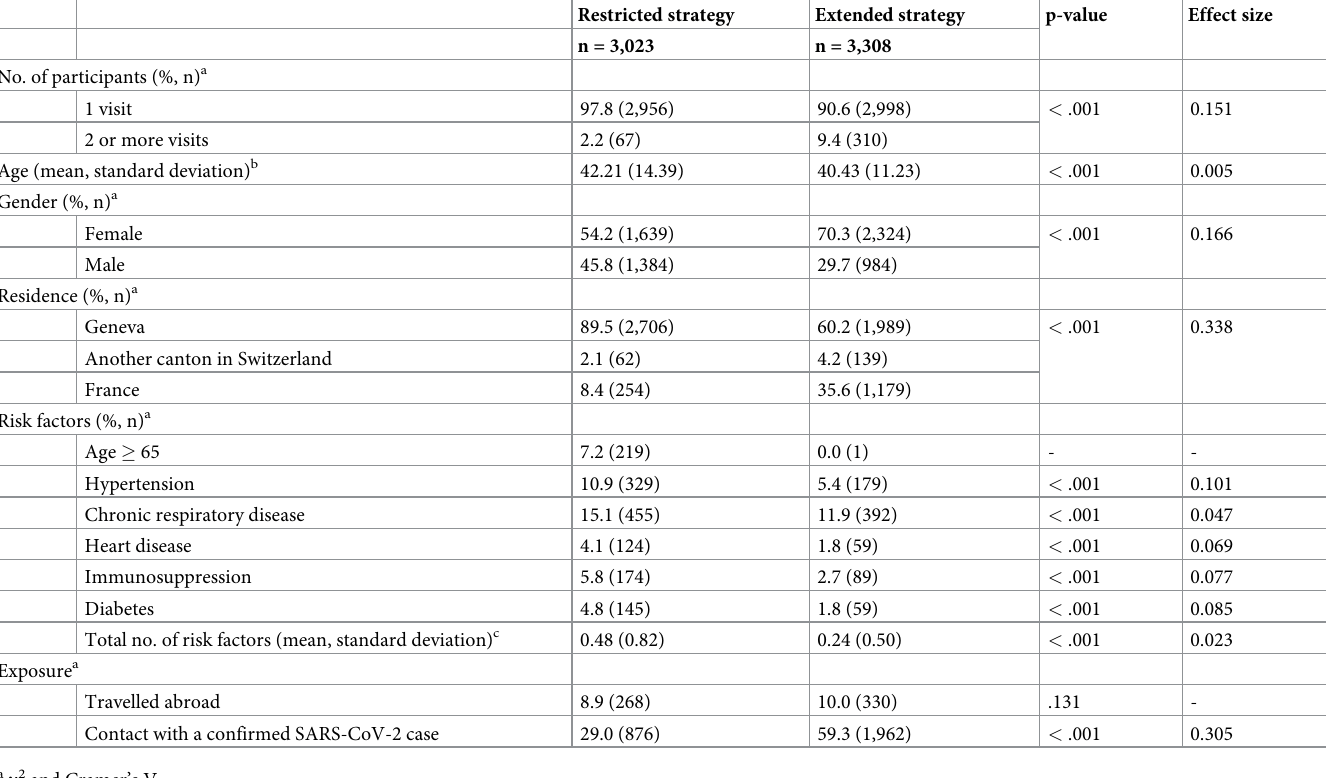
Table 1. Sample characteristics (n = 6,331).